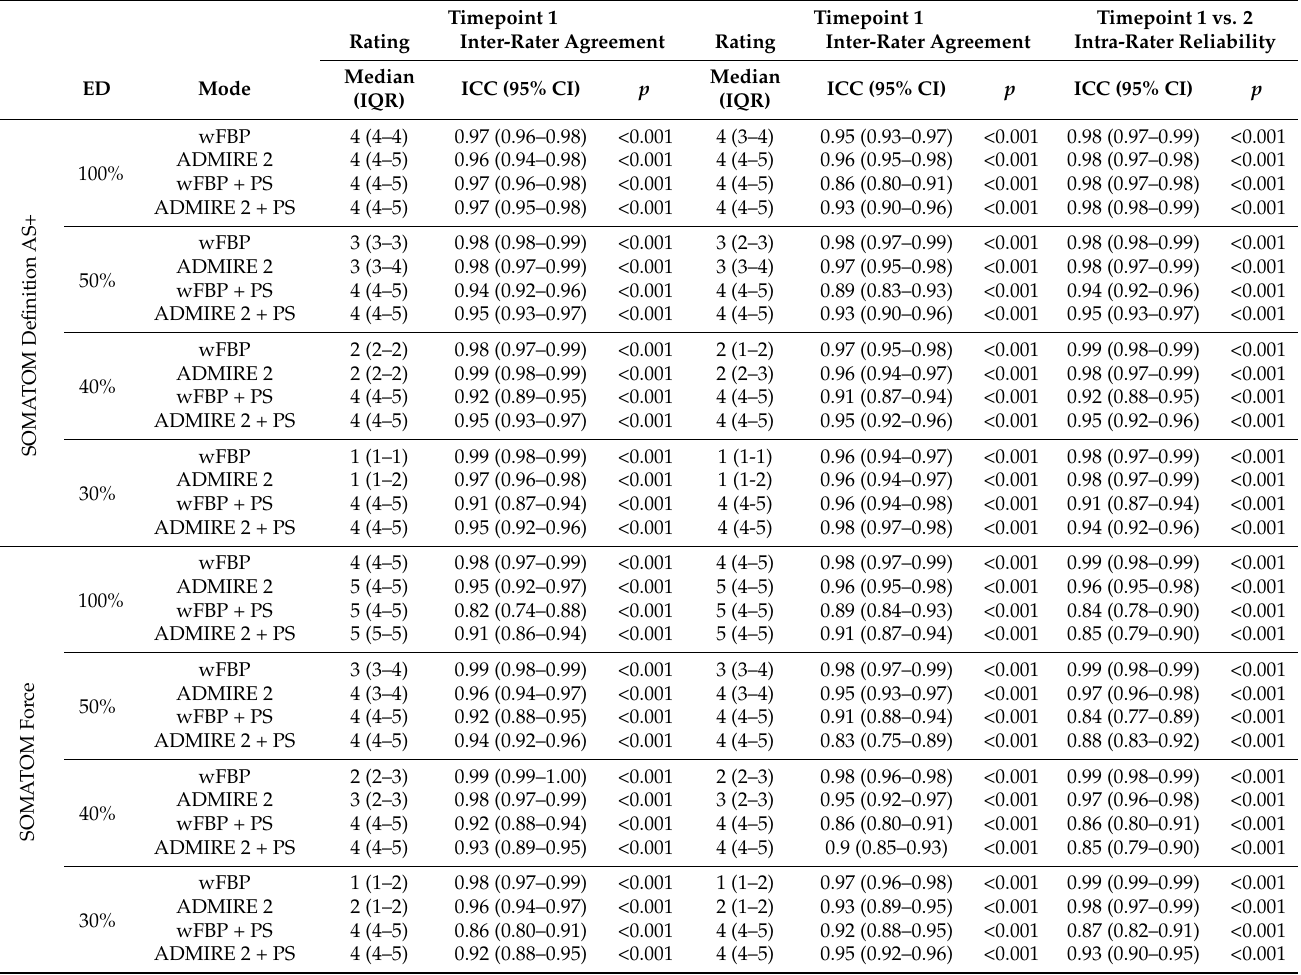
Table 2. Subjective image quality ratings, inter-rater-agreement, and intra-rater